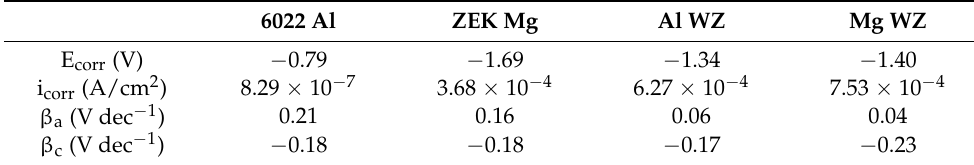
Table 4. Parameters from potentiodynamic polarization